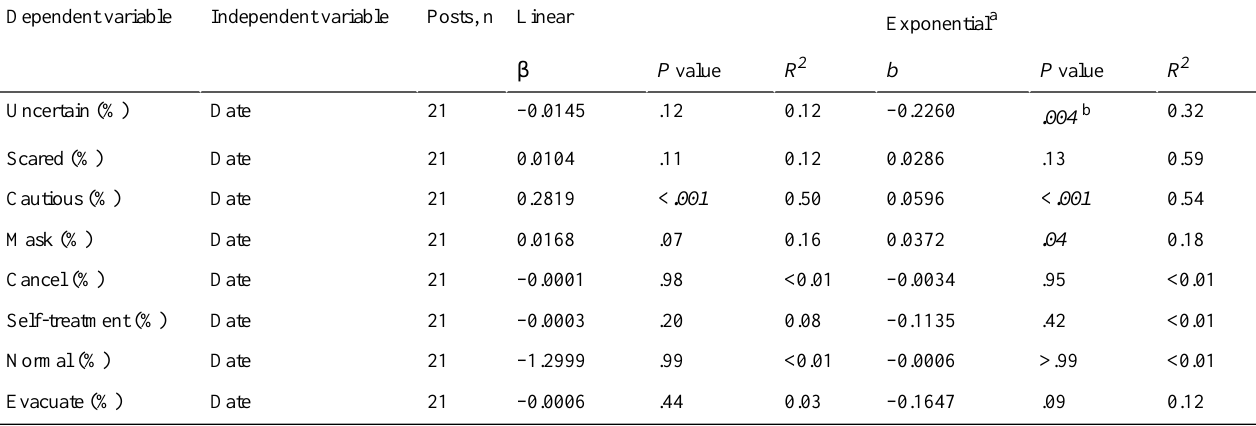
Table 1. Results of eight sets of regression models, corresponding to each of the observed attitudes and reactions from Weibo posts, with each set containing a linear model and an exponential model.